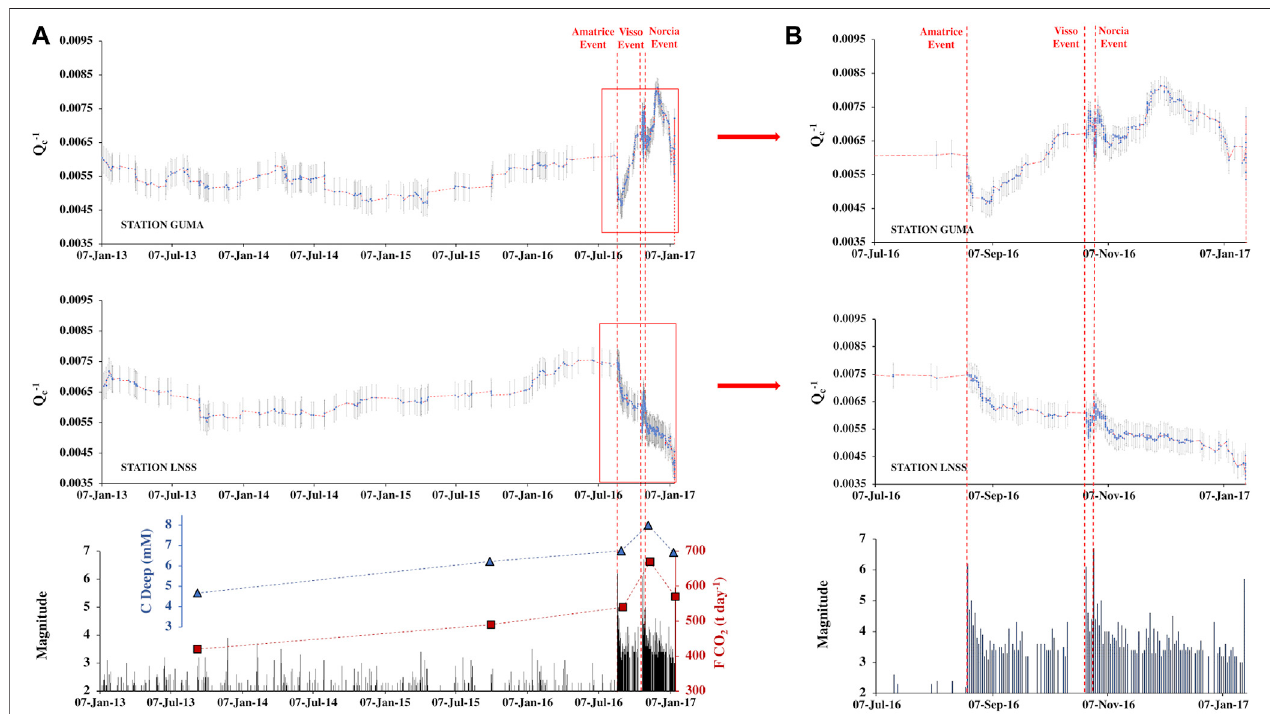
FIGURE 9 | (A) Timelines of the averaged Q c − 1 calculated at 1.5 Hz from the waveforms recorded by stations GUMA and LNNS during the time period of January 2013 – January2017.Thereddashedlineisthemovingmean,andthegraylinesarethestandarderrorbarsfortheQ c − 1 .Timeseriesofthemagnitudeoftheseismicpre- sequenceandsequenceusedinthiswork,comparedwith,inblue,thedeep-CO 2 monitored atCanetraspringand,inred,thedailymeasurementattheVelinoaquiferof the deeply derived CO 2 dissolved in the groundwaters (from Chiodini et al., 2020); (B) the same as (A) , the variations of the averaged Q c − 1 values at two stations observed during the sequence period (from July 2016 to January